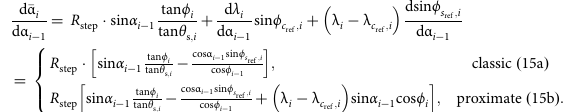
The fi rst square-bracketed terms in Eqs. (15a, b) are identical to the fi xed sun compass (Eq. (14)), re fl ecting seasonal and latitudinal dependence in sun-azimuth. For headings with a Southward component ( α 0 < 90°), the second bracketed terms are always negative, i.e., sensitivity-reducing, resulting in a broad range in latitude and headings with self-correcting headings (Fig. 3c – f). The third bracketed term in Eq. (15b) (for a proximately-gauged TCSC) is also negative, and in fact increasingly so until clocks are reset, but remains small in magnitude compared to the second term.